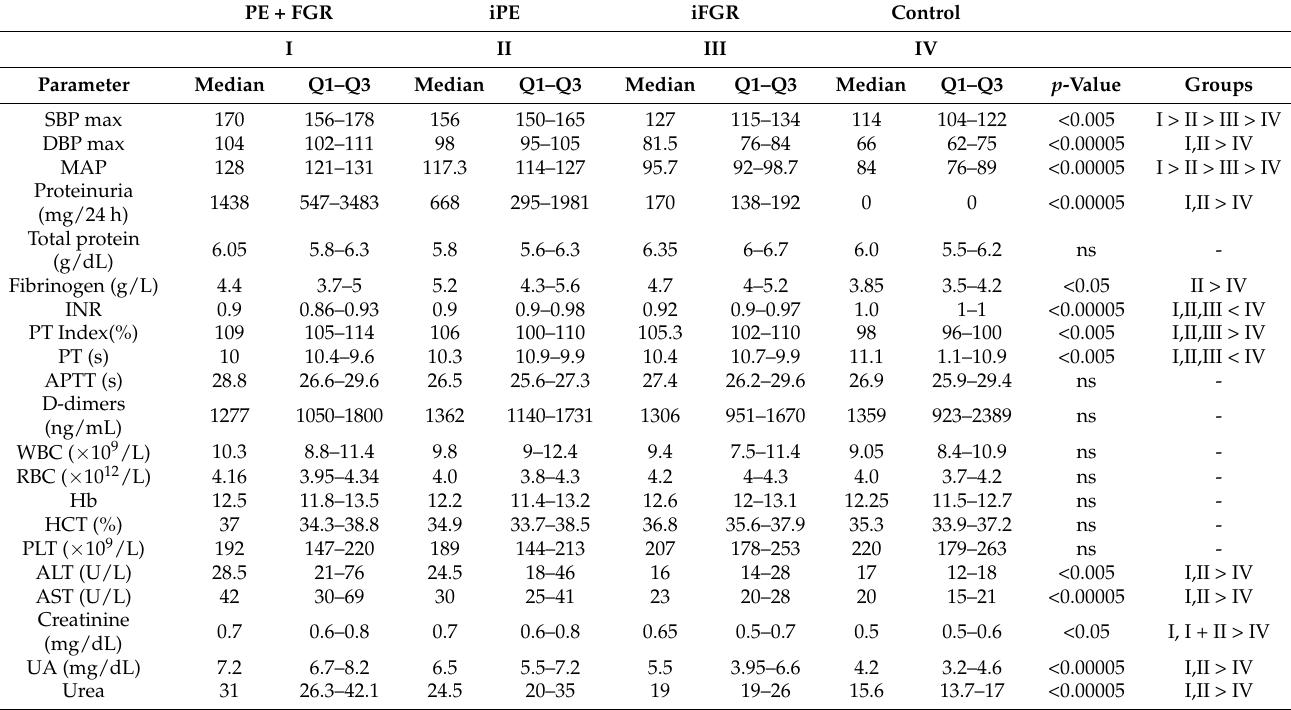
Table 2. Clinical results at the time of evaluation before delivery and statistical analysis of the study groups (based on the results of the Kruskal-Wallis test and analysis of variance ANOVA with a